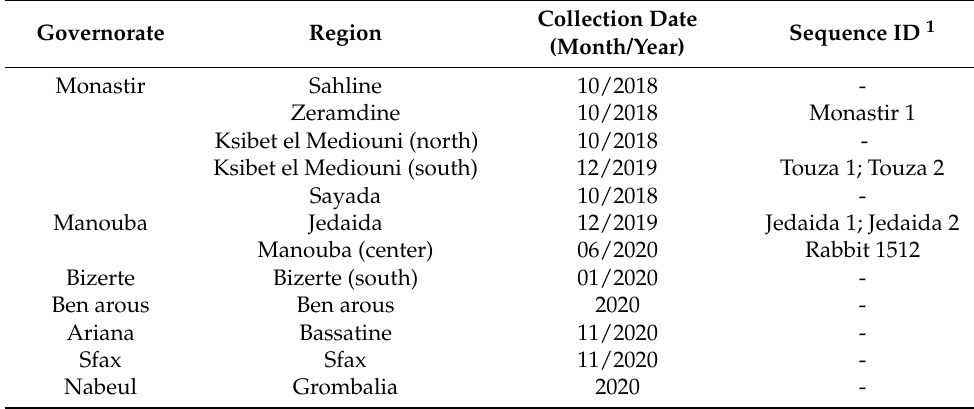
Figure 1. Map with the location of the RHD-suspected dead rabbits sampled from the Tunisian industrial rabbitries between 2018–2020. Table 1. Origin of the rabbits sampled from the industrial rabbitries between 2018–2020.